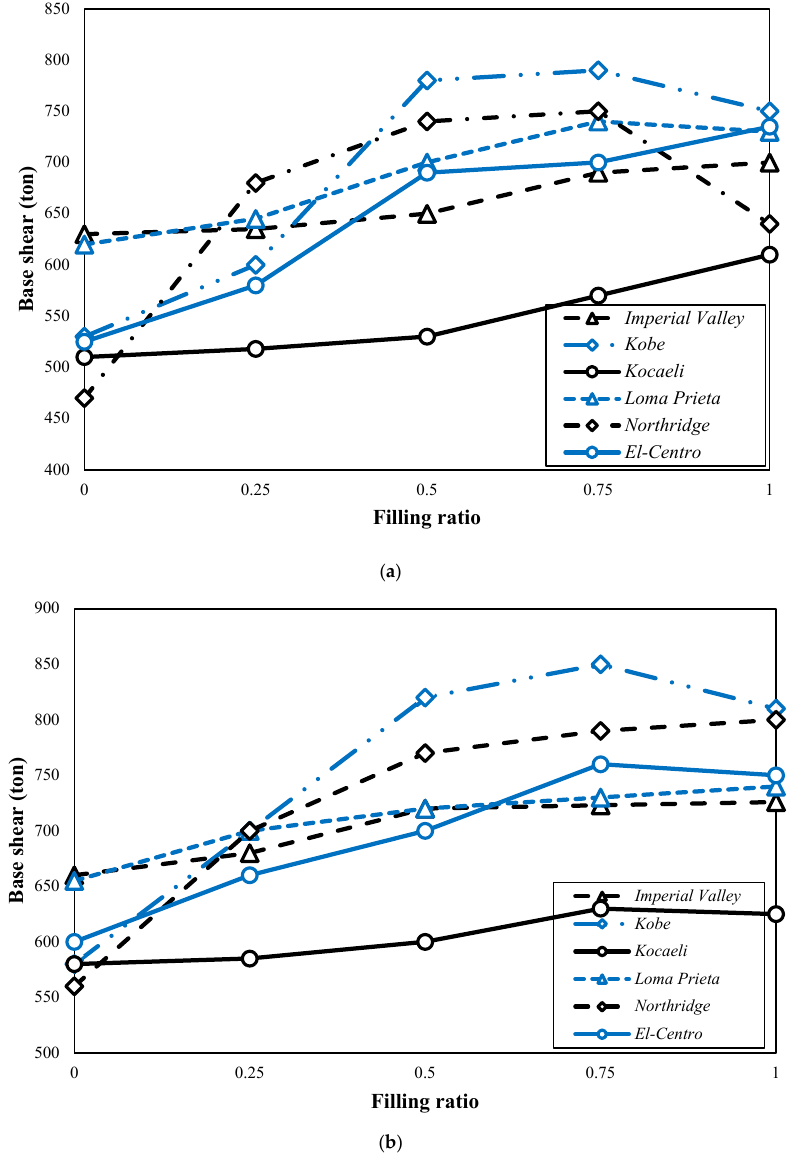
Figure 10. Differences in base shear based on the filling ratio: ( a ) far ‐ fault ground motions and ( b ) near ‐ fault ground motions .